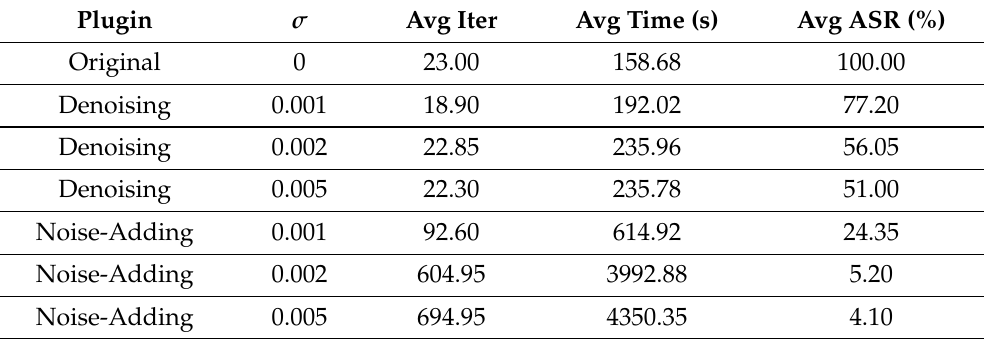
Table 3. Performance evaluation of proposed defense system against FakeBob attacks in GMM SV systems.